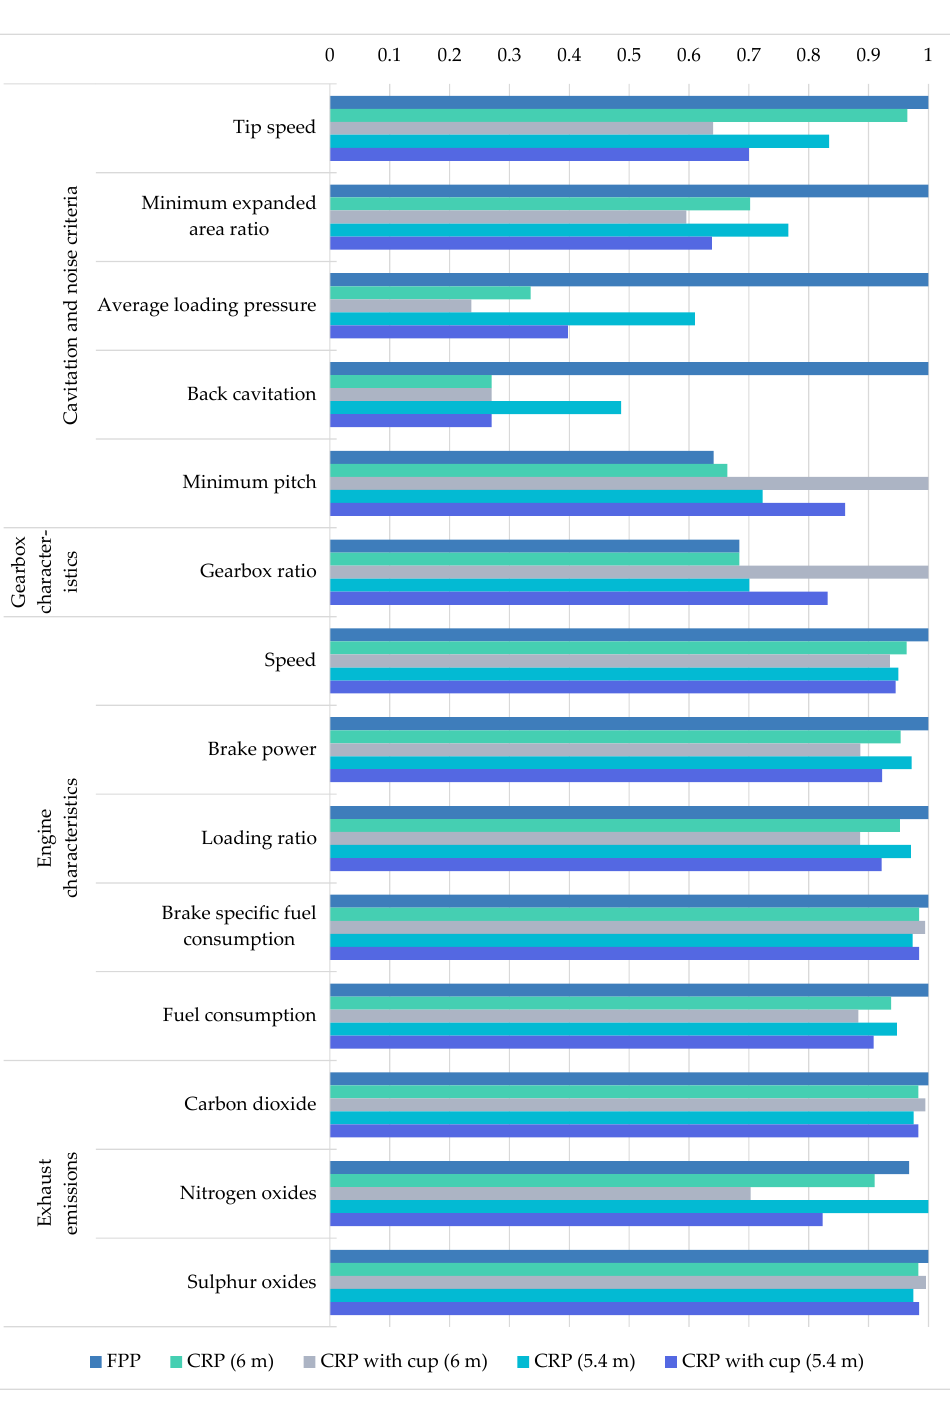
Figure 6. Normalized cavitation criteria, gearbox and engine characteristics and exhaust emissions for different configurations.